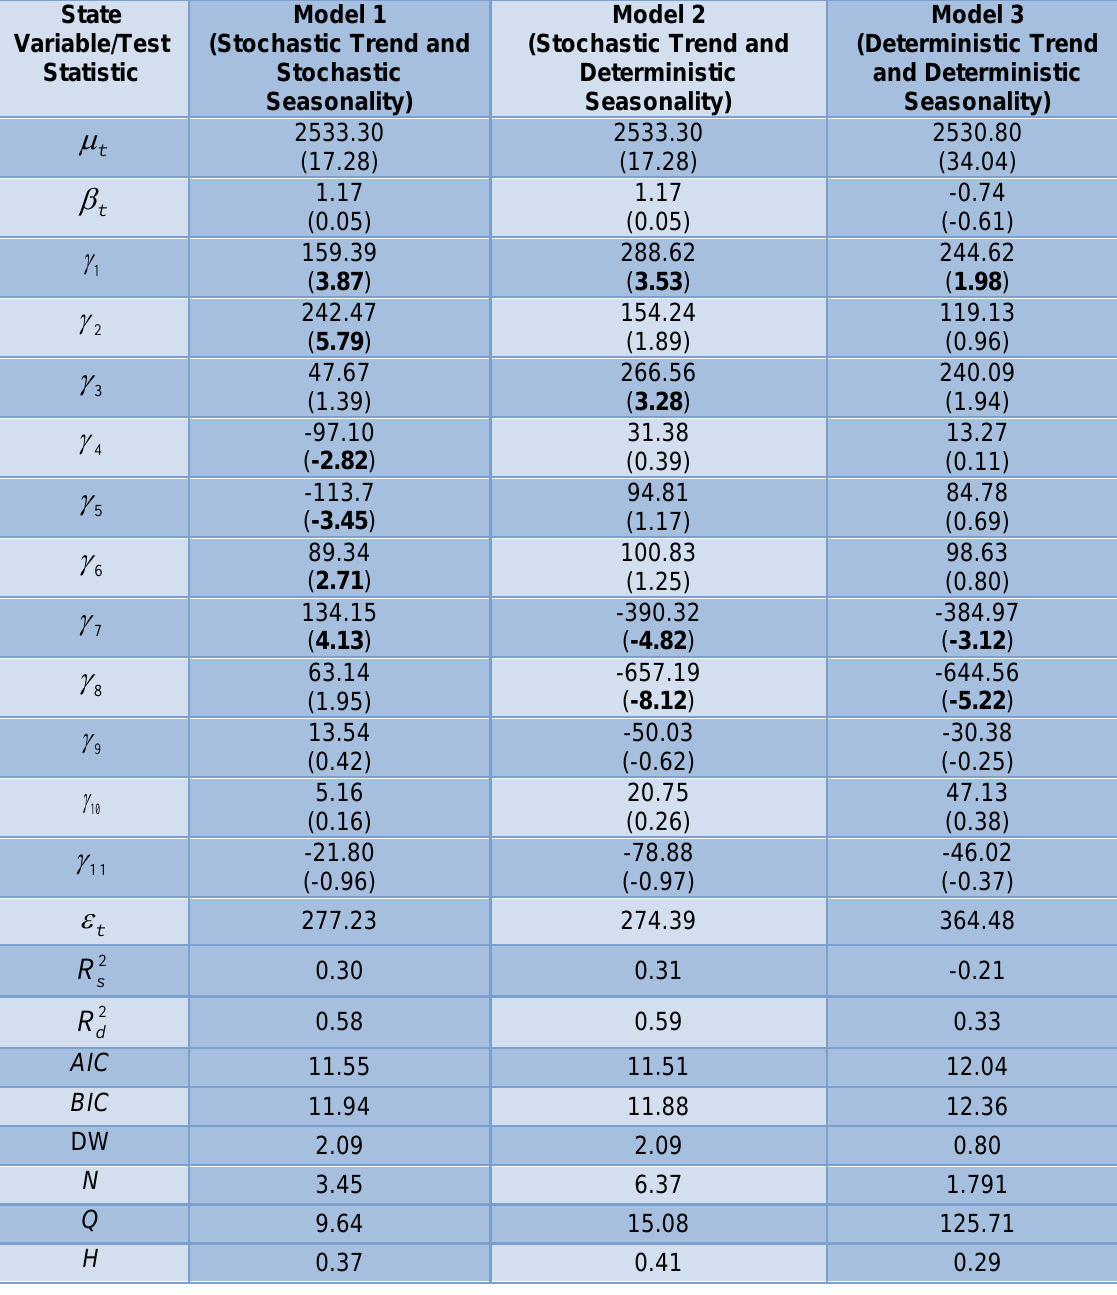
Table 1 Estimated Coefficients of Final State